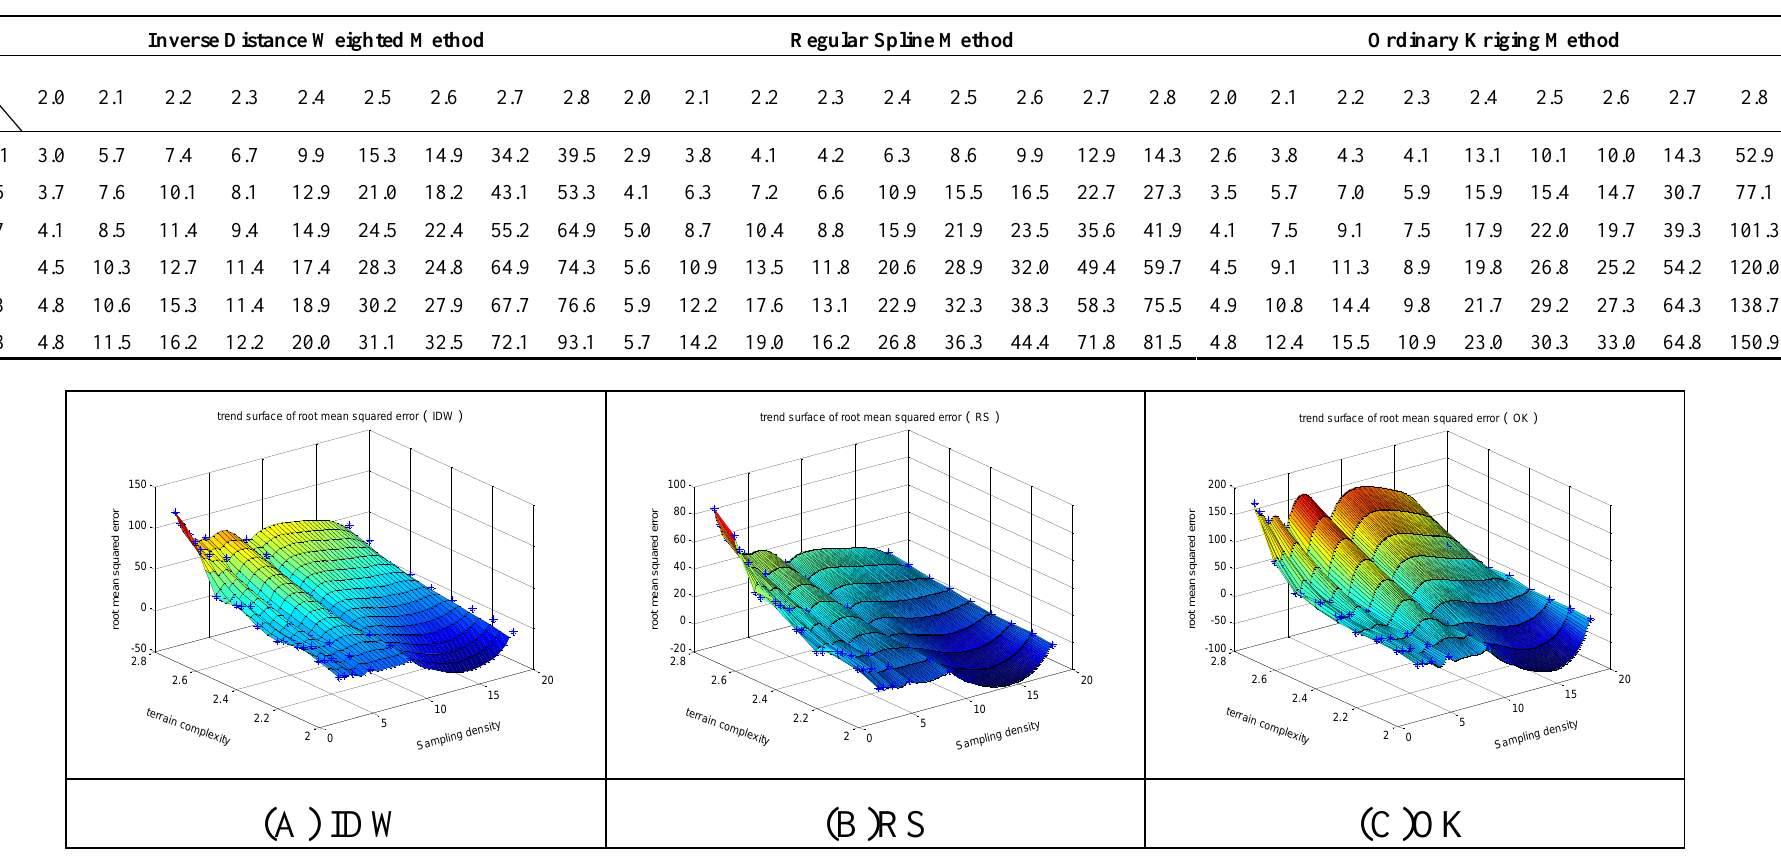
Table 9. The RMSE s under combined sampling mode (Unit: m).